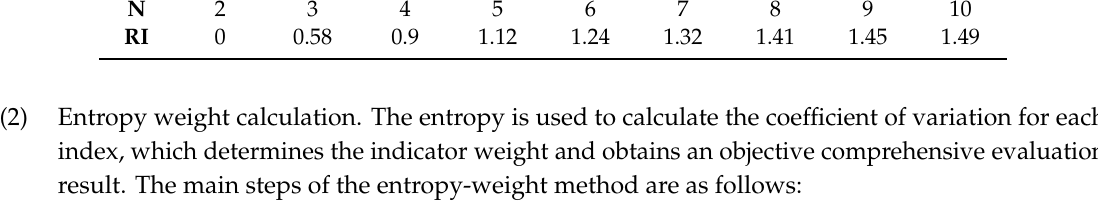
Table 3. Relationship between the randomness index (RI) and the judgment matrix order.